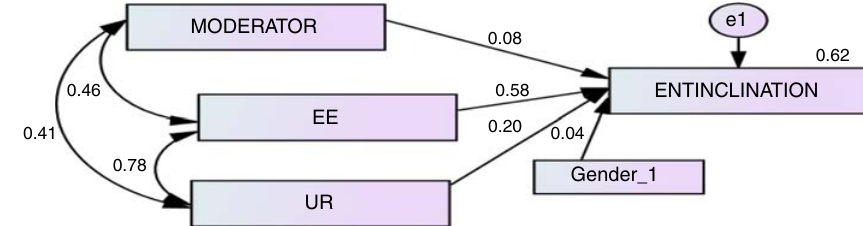
Figure 6. Overall model and moderating effect of role models